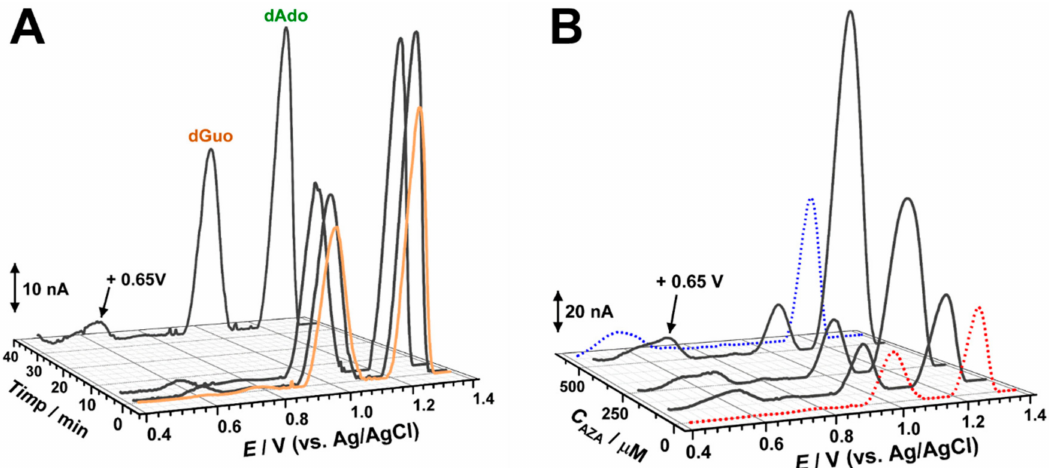
Figure 6. DP voltammograms in acetate buffer (0.1 M, pH 4.5) with the dsDNA biosensor after incubation at − 0.60 V: ( A ) in 100 µ M AZA for 1, 5, and 35 min; ( B ) in 100, 250, and 500 µ M AZA for 10 min. Note: the red dotted curve represents the DP voltammogram with the dsDNA biosensor after incubation at − 0.60 V in buffer; the blue dotted curve represents the DP voltammogram in AZA after applying − 0.60